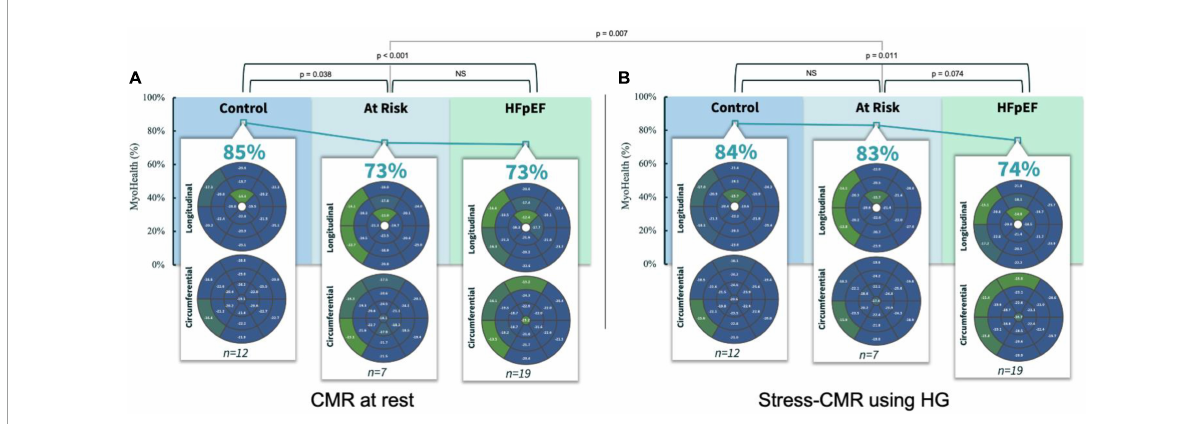
FIGURE1 MyoHealth score at rest (A) and under stress (B) in healthy controls, controls with CV risk factors and HFpEF patients. CMR, cardiovascular magnetic resonance imaging; HG, handgrip exercise; NS, statistically not significant. Preserved regional strain values are blue, altered regional strain values are green. Color code reflects that early affected regions are primarily septal segments. In the at risk group the altered septal segments improve during HG stress, reflected by a color change from green to blue.